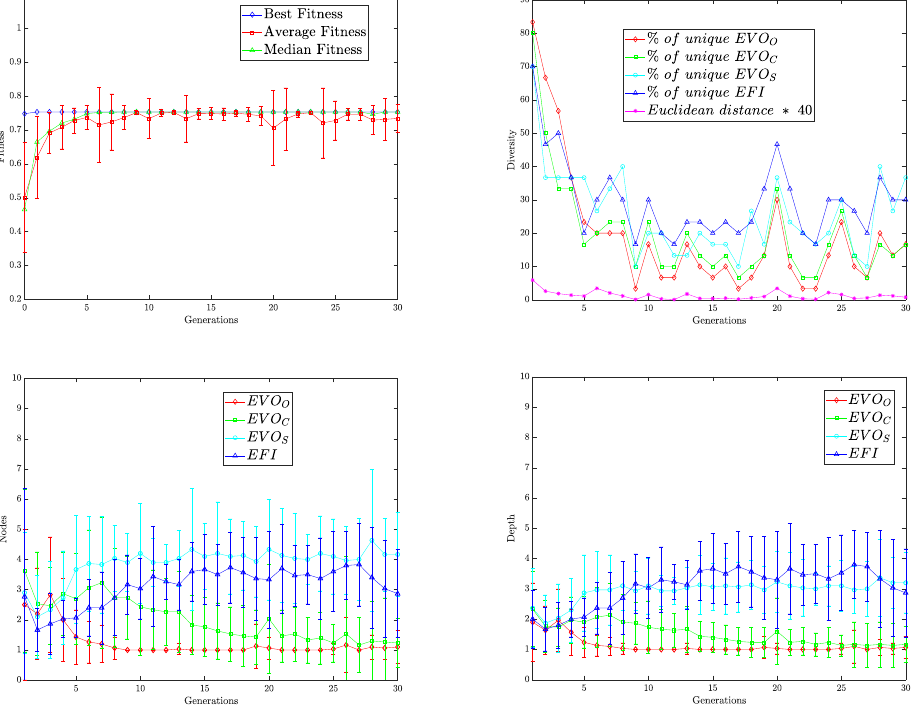
Figure 2. Brain programming statistics of the run corresponding to the best GBVSBP model for the FT database. We observe the convergence of fitness, diversity of solutions, number of nodes, and depth of solutions. It seems that the total number of generations can be reduced to